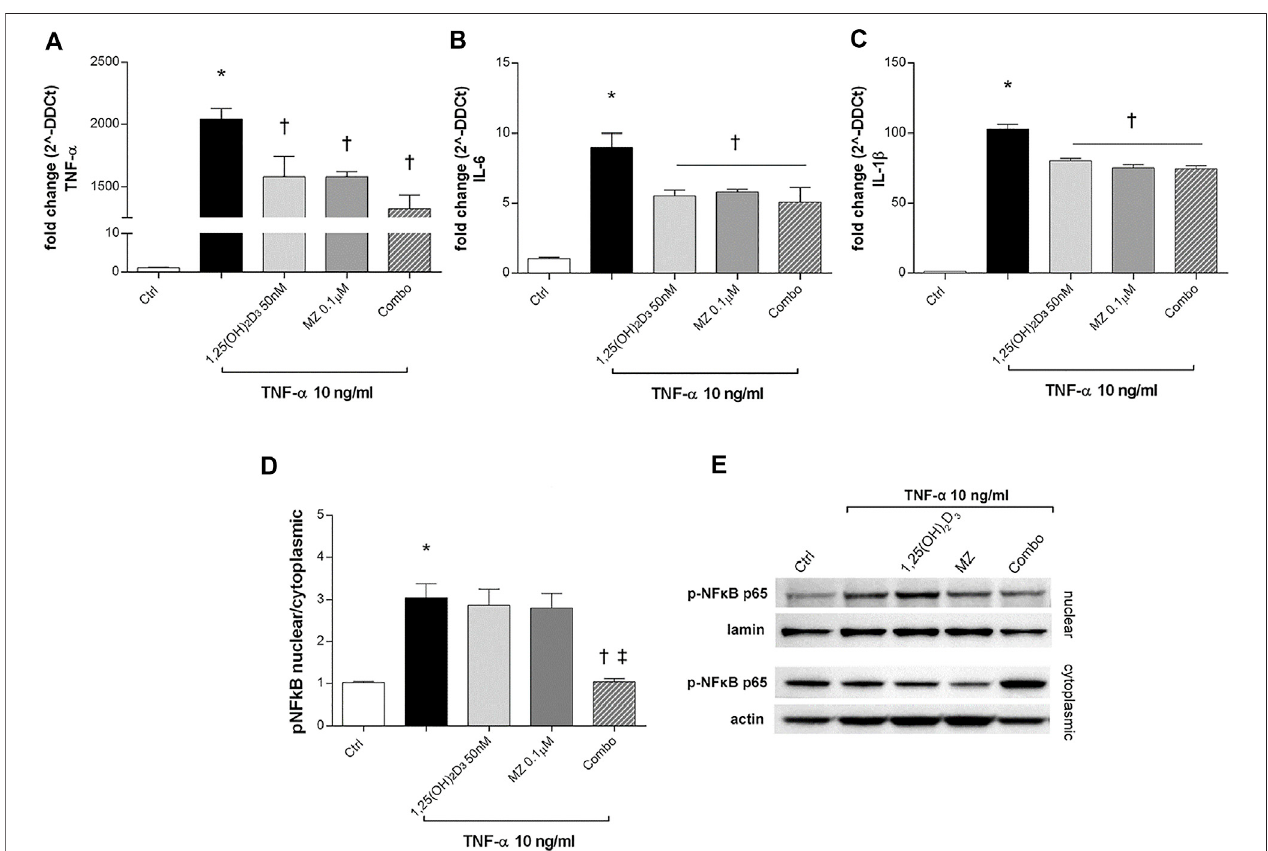
FIGURE 6 | 1,25(OH) 2 D 3 , meso-zeaxanthin (MZ), and the combination inhibit LPS-induced in fl ammation. 1,25(OH) 2 D 3 , meso-zeaxanthin (MZ), and their combo reduced TNF- α (A) , IL-6 (B) , and IL-1 β (C) mRNA expression. ARPE-19 cells were pretreated for 24 h with 1,25(OH) 2 D 3 (50 nM), MZ (0.1 µM), and their combo (1,25(OH) 2 D 3 50 nM + MZ 0.1 µM), and then challenged with TNF- α (10 ng/ml) for 2h, both for mRNA and protein analyses. The mRNA levels were evaluated by qPCR. (D) Densitometric analysis of each band (ratio of nuclear p -NF κ B p65/lamin B and cytoplasmic p -NF κ B p65/actin) was carried out with the ImageJ program. (E) Representative images of nuclear and cytoplasmic proteins. Each bar represents the mean value ± SD ( n (cid:2) 5; each run in triplicate). Data were analyzed by one-way ANOVA and Tukey ’ s post hoc test for multiple comparisons. * p < 0.05 vs. control; † p < 0.05 vs. TNF- α ; ‡ p < 0.05 vs. 1,25(OH) 2 D 3 and MZ.